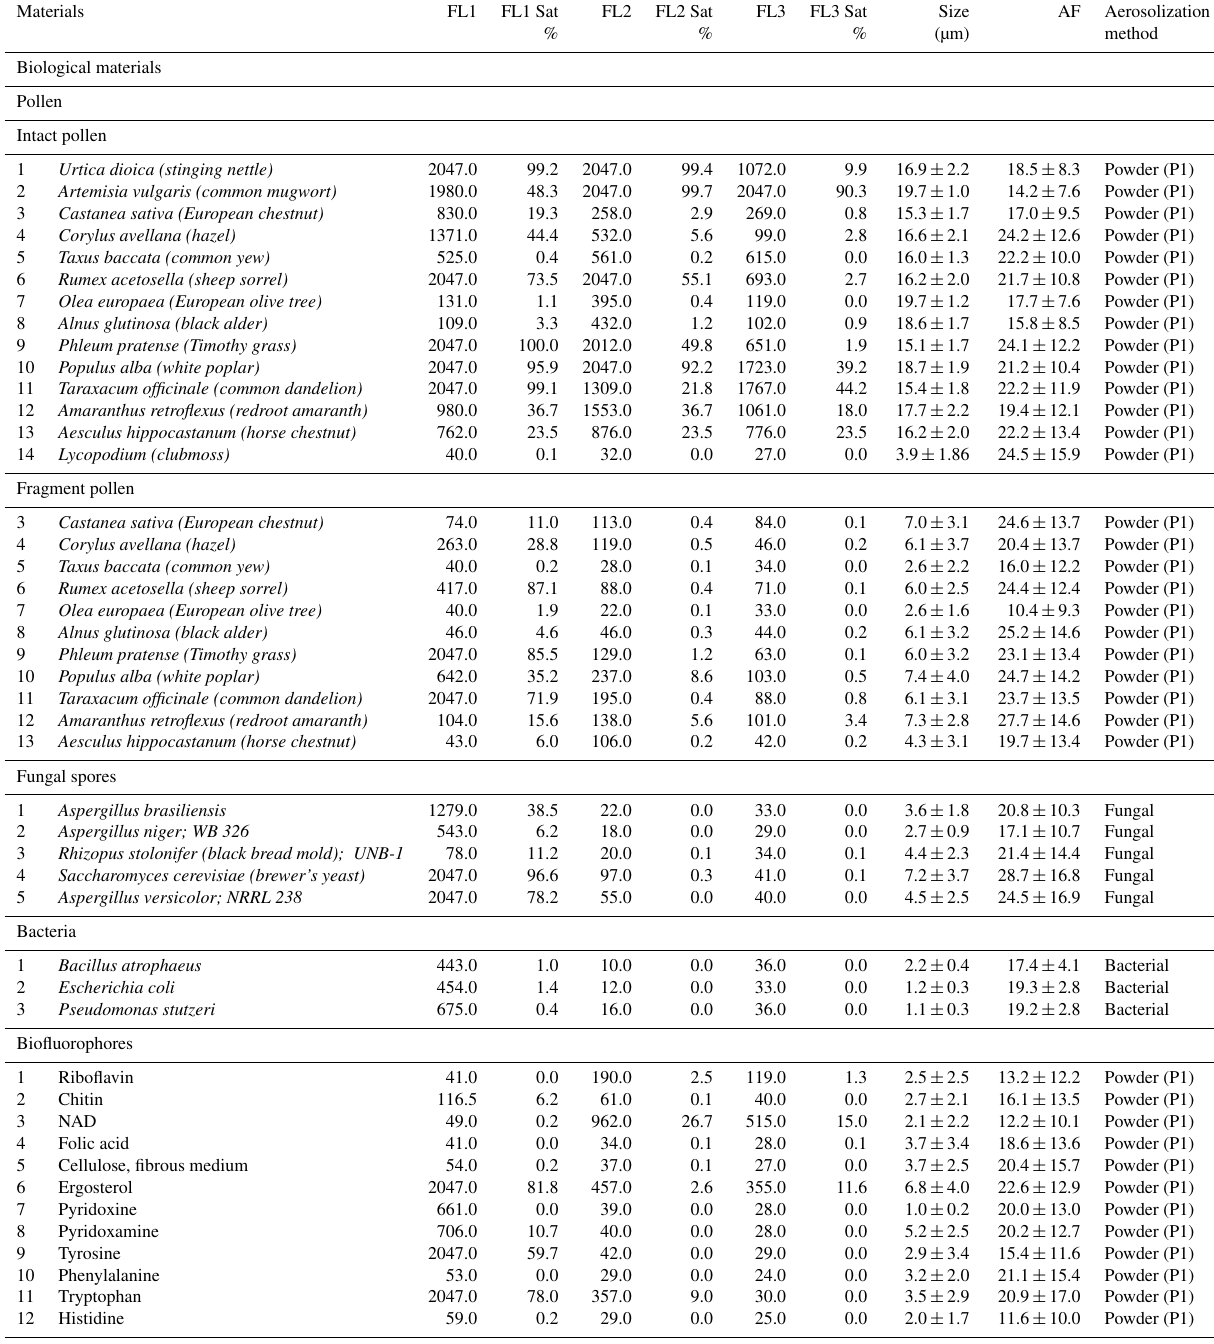
Table 2. Median values for each of the five data parameters, along with percent of particles that saturate fluorescence detector in each fluorescence channel. Uncertainty (as 1 standard deviation, σ) listed for particle size and asymmetry factor (AF). Only a sub-selection of pollen are characterized as fragmented pollen because not all pollen presented the smaller size fraction or fluorescence characteristics that represent